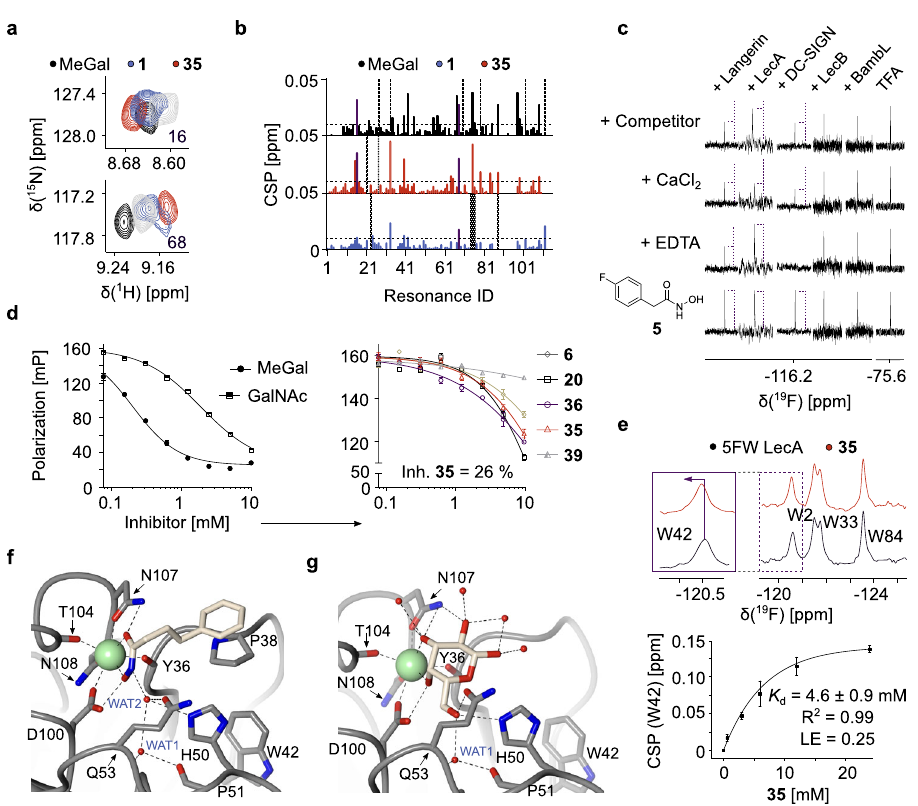
Fig. 2 Hydroxamates as drug-like inhibitors of PA-IL (LecA). a Examples of the residues in the carbohydrate-binding site of 15 N LecA in TROSY NMR in the presence of DMSO ( gray ), 3 mM 1 ( blue ), 35 (red) or 1 mM methyl α -D-galactoside (MeGal, black ). b Quantitative analysis of the chemical shift perturbations (CSPs > 0.01 ppm, dashed line ) and changes in the peak intensity ( dotted line ) promoted by 1 , 35 and MeGal. The resonances 16 and 68 were highlighted ( violet ) showing hydroxamates perturbed the residues similarly to MeGal. c Shown is a Ca 2 + -dependent binding of 0.01 mM LecA to 5 ( dashed line ) in the competitive 19 F T 2 - fi ltered NMR, as evident by a decrease and recovery of the spy 5 with Ca 2 + (10 mM CaCl 2 ) and without (2 mM EDTA), respectively. Moreover, 5 -LecA interaction showed a higher selectivity over other non- and Ca 2 + -dependent lectins. d Competitive binding assay based on fl uorescence polarization with MeGal and GalNAc ( left ) as positive controls for strong and weak ligands, respectively. The hydroxamates 6 , 20 , 35 , 36 and 39 (right) demonstrated LecA-dependent inhibitory properties. Inhibition values of compounds were derived at 10 mM and referenced to MeGal (16 h). e Shown is PrOF NMR of 0.15 mM 5FW LecA with 3 mM 35 ( upper panel ) binding to the carbohydrate pocket as evident by a CSP of W42. One-site binding model of 35 ( bottom panel ) used to derive the af fi nity (K d ) by following CSPs of W42. The error bars are showing the mean (n = 3). The K d values were used to calculate LE. f Crystal structures show the interactions between LecA and 35 (PDB: 7FJH) and ( g ) galactose (PDB: